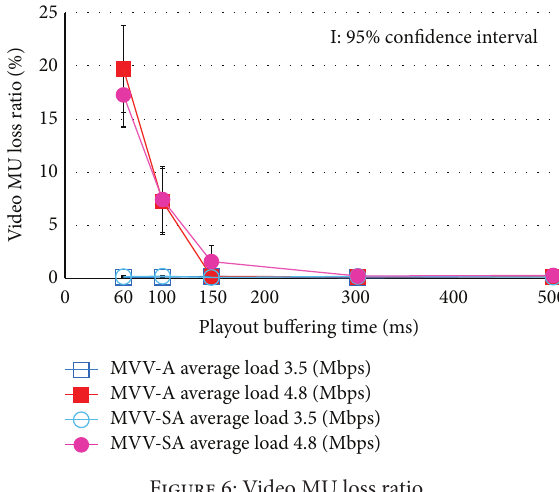
Figure 5: Audio MU loss ratio. Figure 6: Video MU loss ratio.